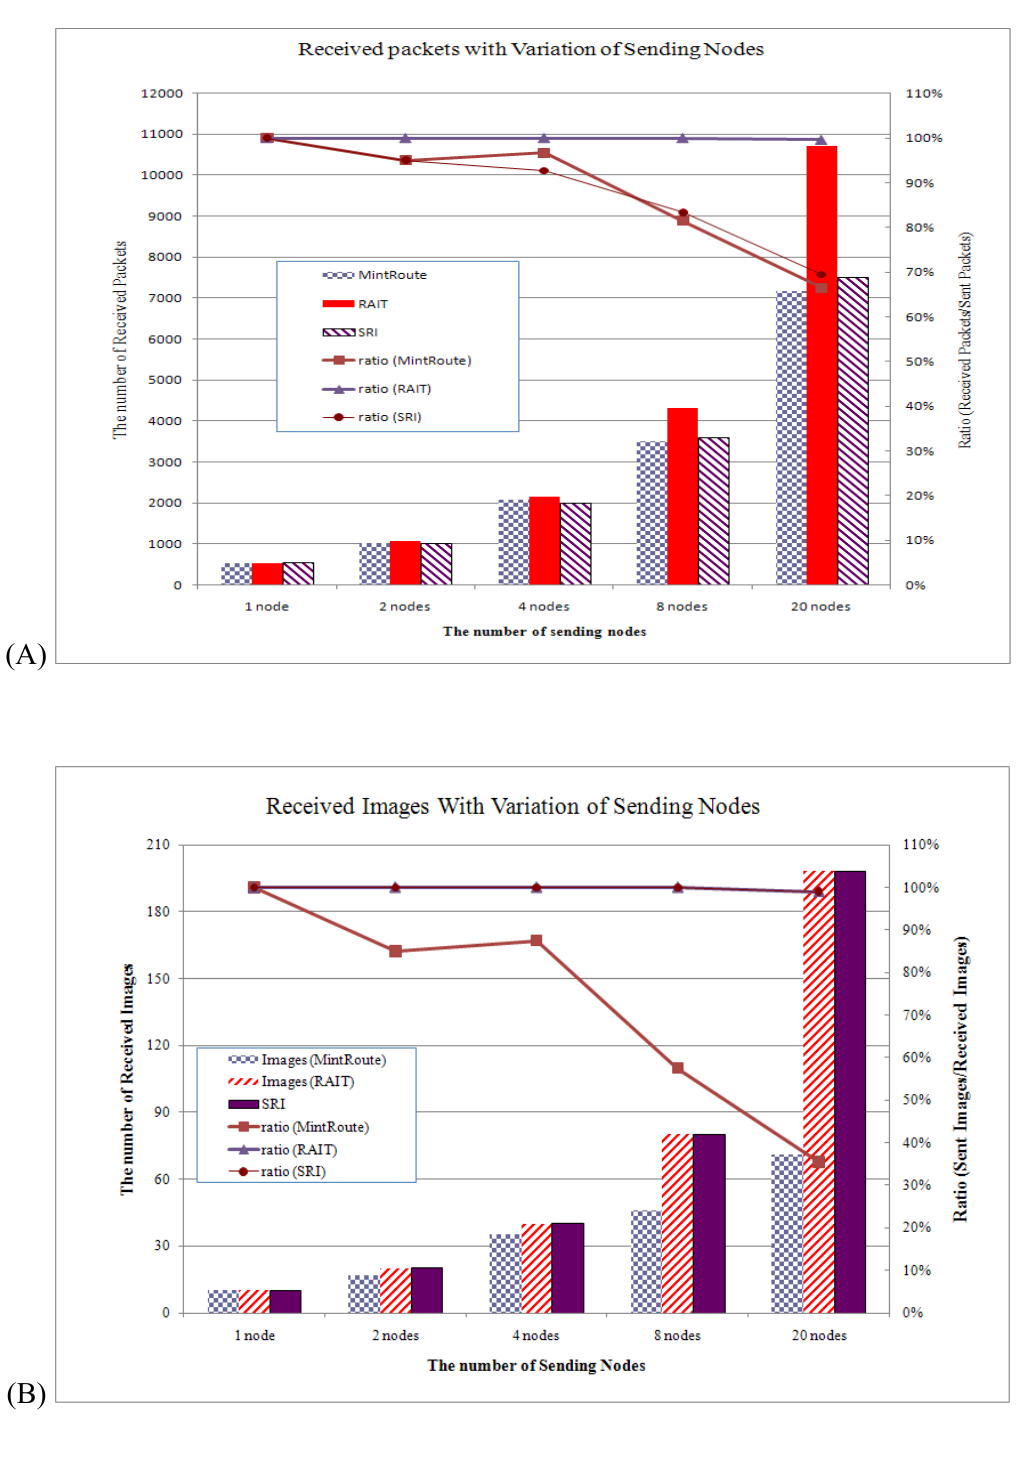
Figure 10. Number of received packets (A) and number of received images (B) with variations in number of sending nodes. RAIT collected whole packets of transferred images while the reception ratio with MintRoute and SRI was decreased in an inverse proportion to the number of sending